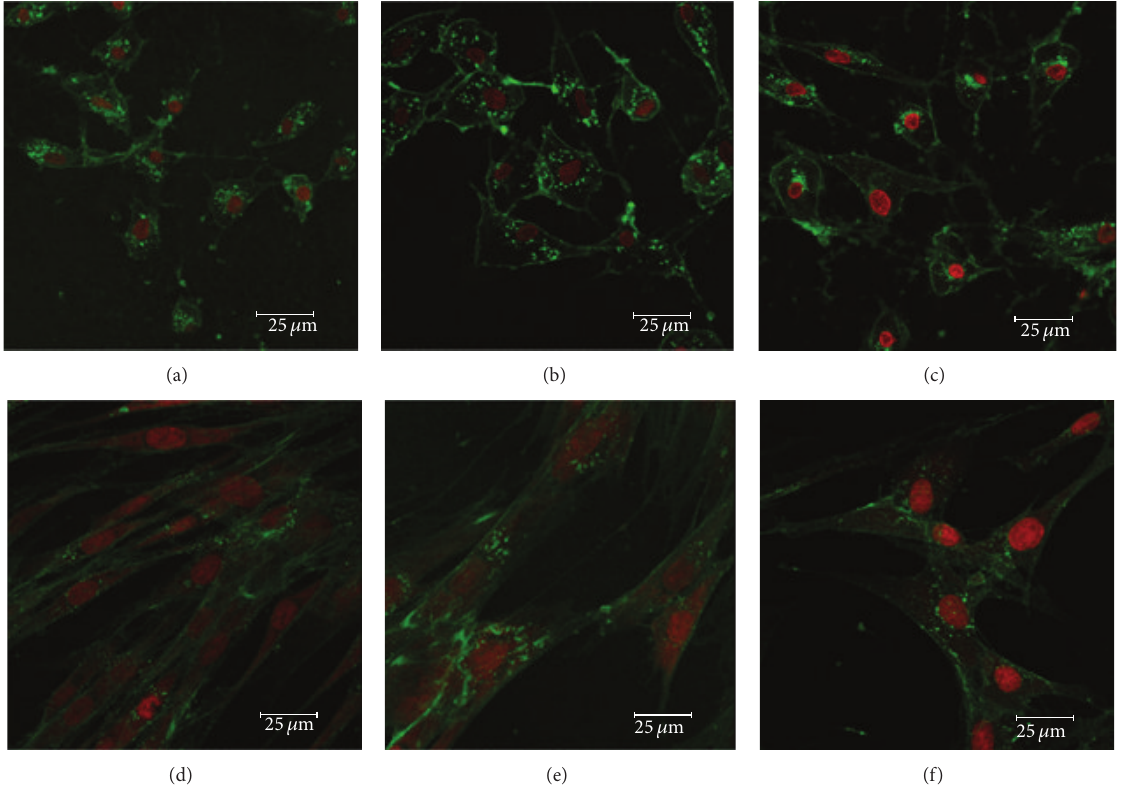
Figure 5: Nuclear/cytoplasmic staining of neural-like eBM-MSCs. Representative confocal images of cytoplasmic (WGA) and nuclear (TO- PRO-3-iodide) fluorescent stains showing the integrity of neural crest-like cells from low passaged eBM-MSCs of one young (a) and one middle-aged (b) horse and from high passaged eBM-MSC of middle-aged (c) horse. Note the typical fibroblast-like morphology of the undifferentiated MSCs (d, e, and f). Scale bar = 25 𝜇